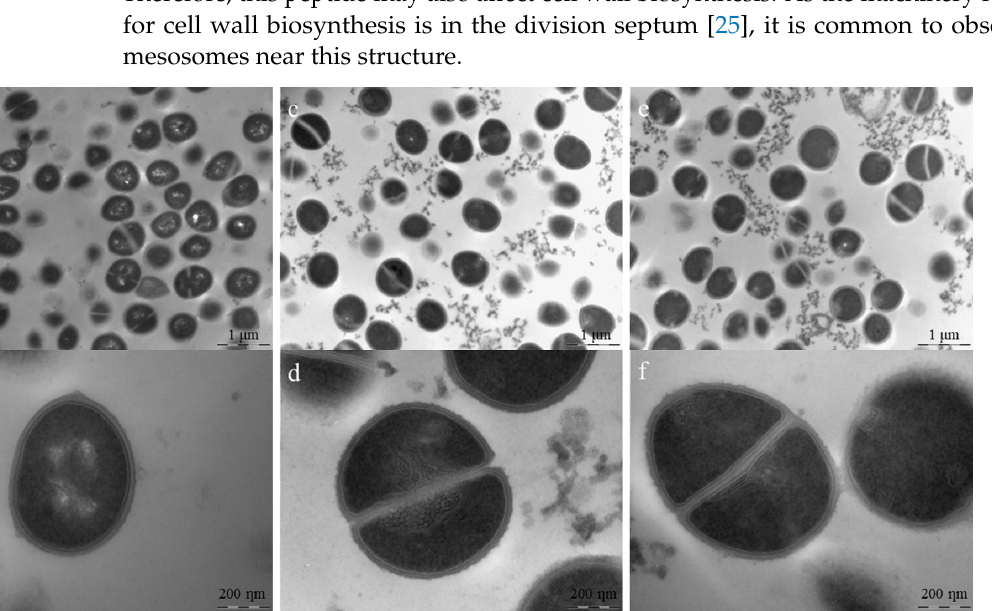
Figure 6. TEM for S. aureus ATCC 25923 treated with Pln149-PEP20 (MIC = 8 mg/L). ( a ) non-treated cells. Scale bar = 1 µm ( b ) non-treated cell in detail, with intact cell wall and membrane. Scale bar = 200 nm ( c ) 1 × MIC treated cells, showing cell debris and deficient cells. Scale bar = 1 µm ( d ) 1 × MIC treated cells in detail, showing cell debris, cell with defective division septum, and intralamellar structures. Scale bar = 200 nm ( e ) 4 × MIC treated cells, showing cell debris and deficient cells. Scale bar = 1 µm ( f ) 4 × MIC treated cells in detail, showing cell with defective division septum, intralamellar structures, and diffuse membrane. Scale bar = 200 nm .